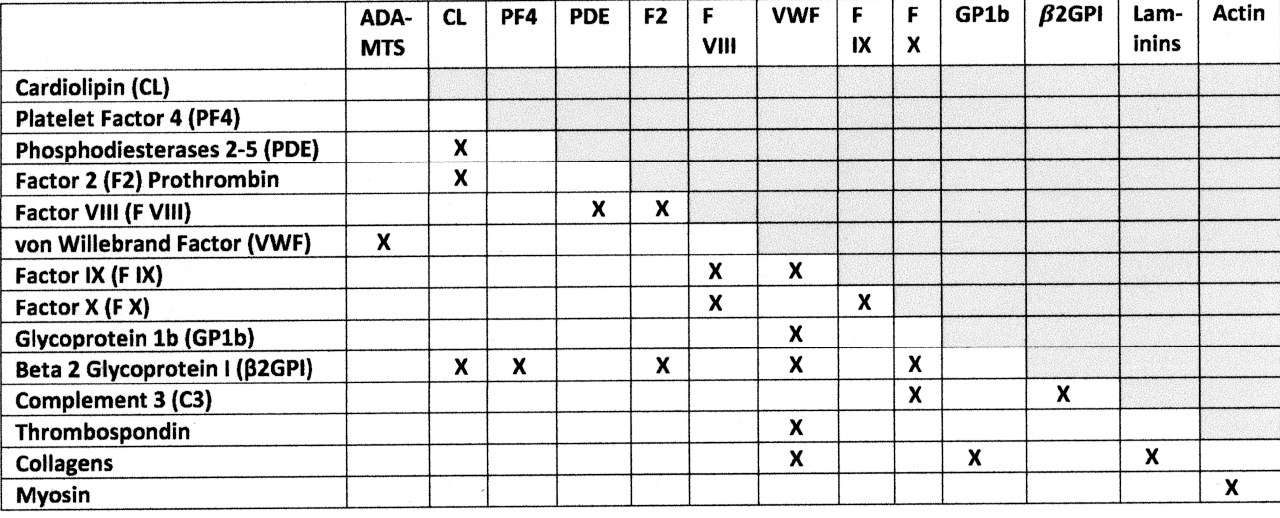
Figure 15. Summary of known binding interactions (i.e., autoantigen complementarity) reported among the various human protein targets of autoimmunity discussed in this paper (adapted from [70]). X indicates that the pair of proteins are known to bind to each other and thus display complementary regions. The abbreviations for the top row are provided in the left-hand column. Background shading blocks off duplicate entries.